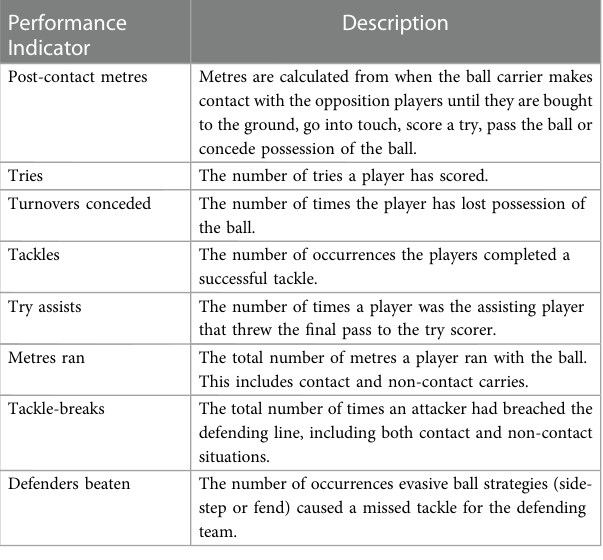
TABLE 1 Performance indicators